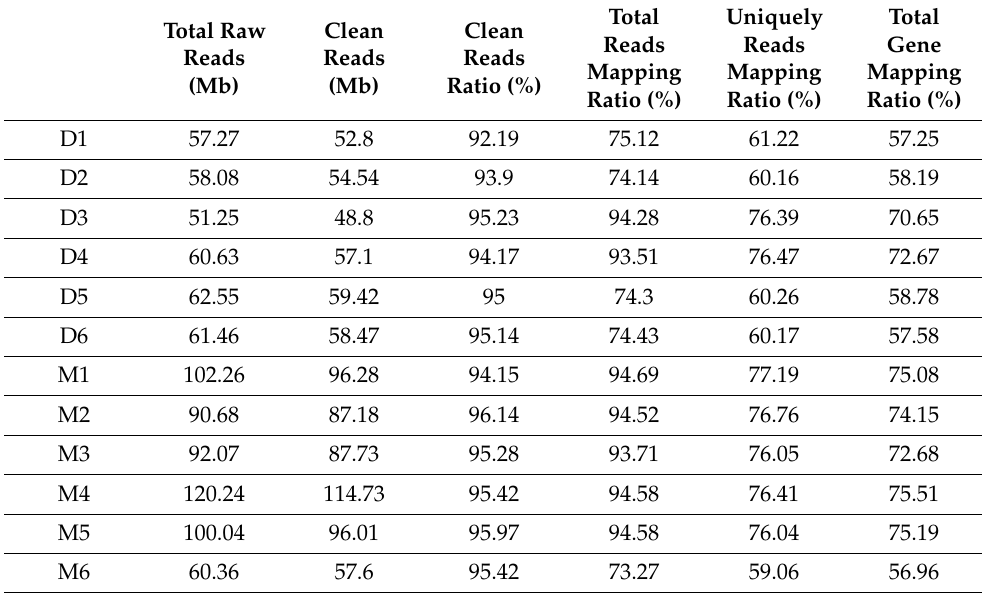
Table 1. Quantity and quality characteristics of the RNA-Seq